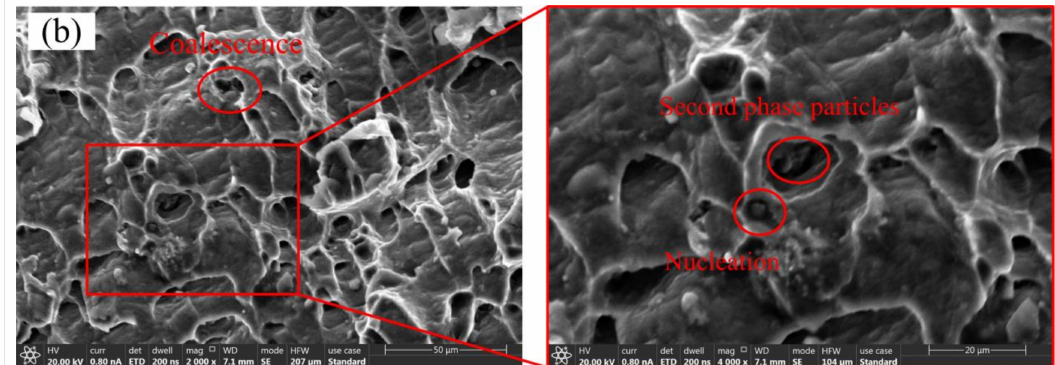
Figure 12. Fracture morphology of samples with different widths at a deformation temperature of 360 ◦ C ( a ) w = 80, ( b ) w = 200 (as shown in Figure 7).